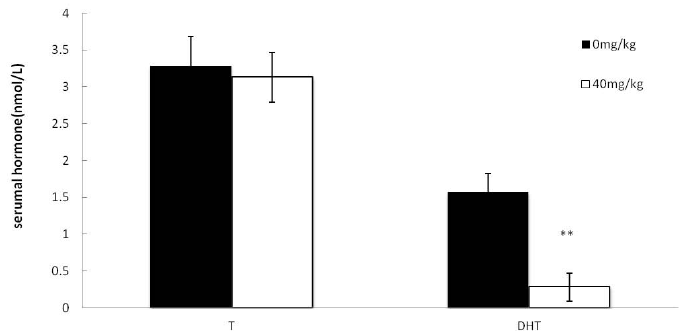
Figure 5. Effect of dutasteride treatment on serum T and DHT levels. Data are represented as mean ˘ SEM. ** p < 0.01 versus the control group, n = 8.